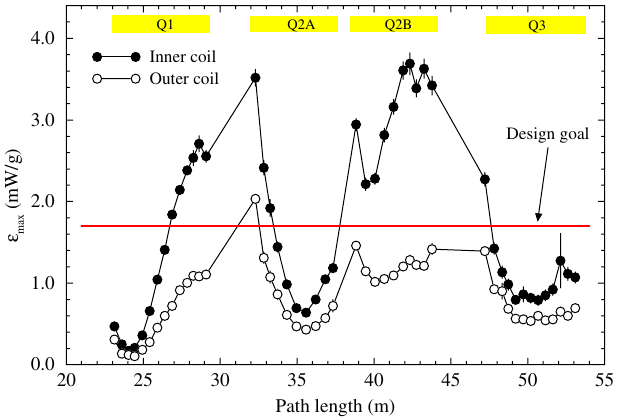
FIG. 4. (Color) Distribution of peak power density along the inner triplet for 90-mm Nb Sn quadrupoles with a baseline 3 stainless steel